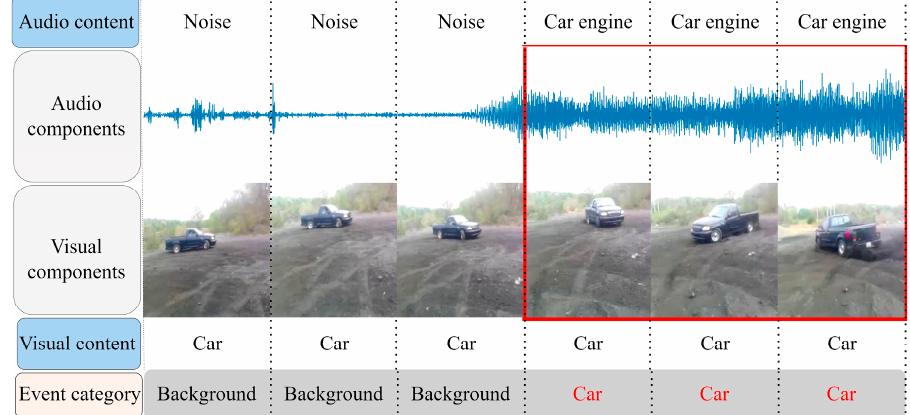
Figure 1. An illustration of the AVE localization task.